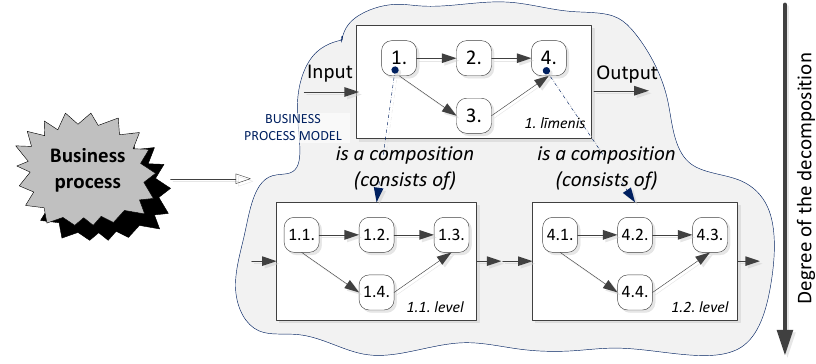
Figure 5. Business process modeling at the different decomposition levels